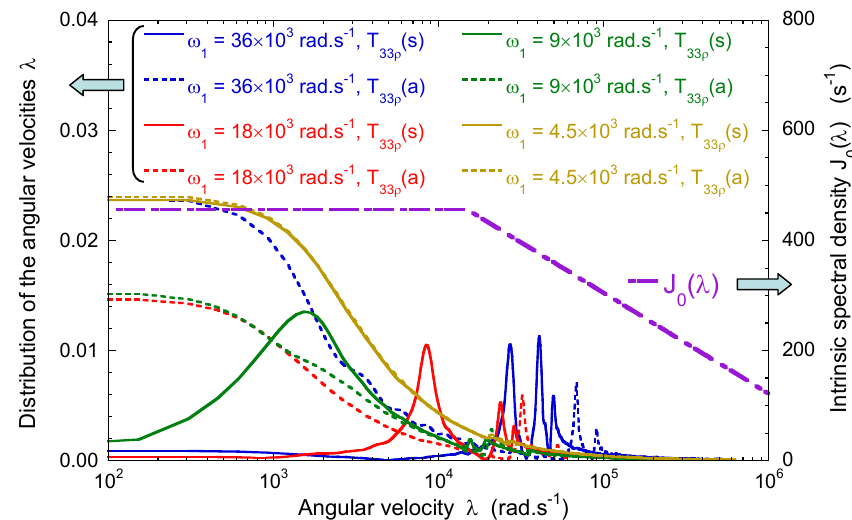
Figure 10. Distribution of the complete set of resonance angular velocities probed by the triple-quantum filtered relaxation measurements under the spin-locking condition performed at four irradiating fields ω 1 , evaluated from the intrinsic spectral density J 0 ( λ ) ( 7 Li NMR). Reprinted with permission from [54]. Copyright (2009) American Chemical Society.